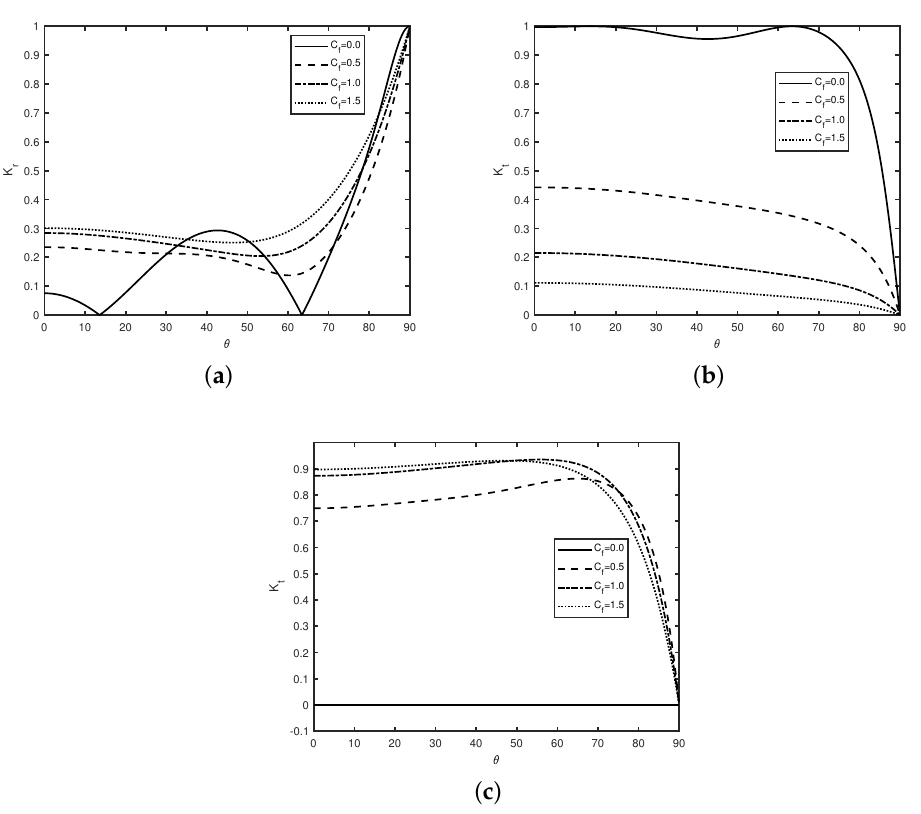
Figure 8. Variation of ( a ) reflection coefficient K r , ( b ) transmission coefficient K t , and ( c ) dissipation coefficient K d versus angle θ for different values of C f with d / h 1 = 2, width w / h 1 = 1.0, h 2 / h 1 = 0.25, and N =